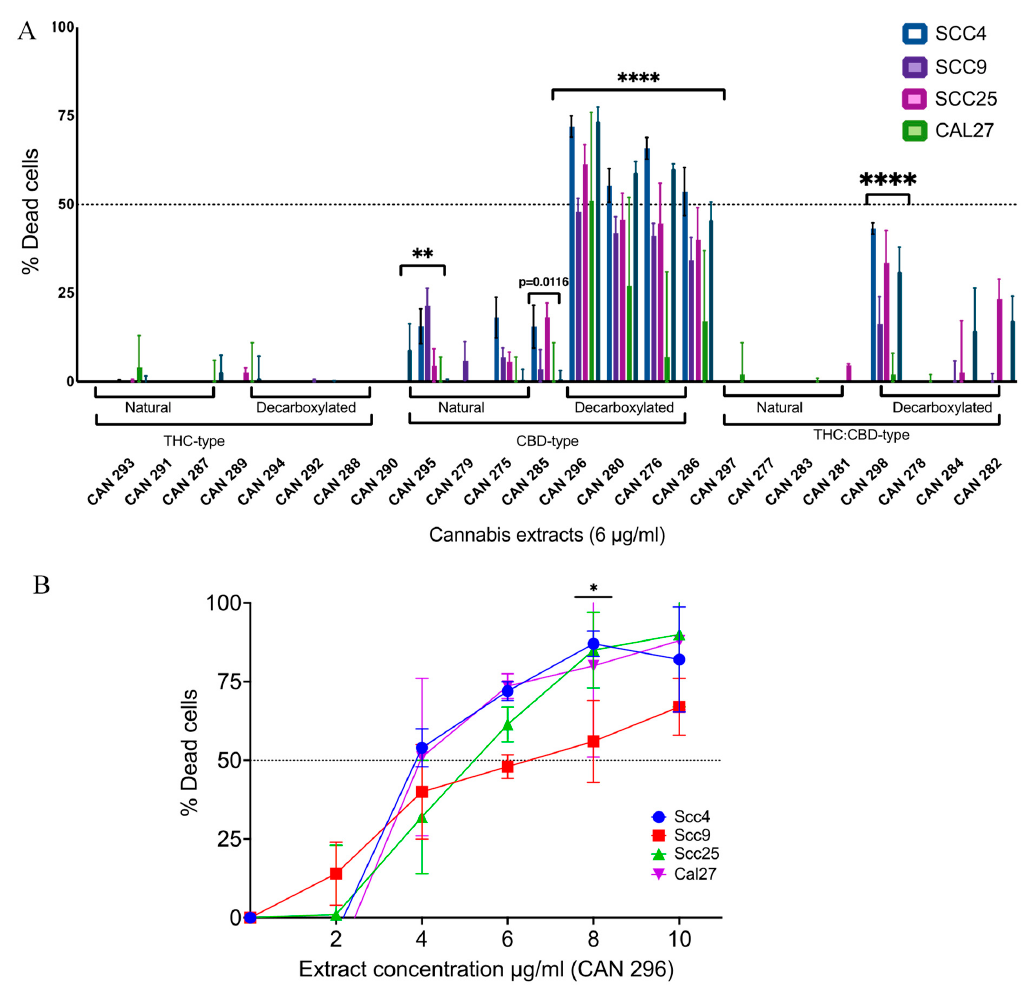
Figure 2. Differential effect of different Cannabis extracts on the viability of HNSCC cells. ( A ) Cell viability of HNSCC cell lines Scc4, Scc9, Scc25, and Cal27 following treatment with 24 cannabis extracts at 6 μ g/mL concentration for 24 h. Cell viability was evaluated by MTT, and data are reported as mean ± SE (n = 3) of % dead cells compared to DMSO control, % Dead cells = 100